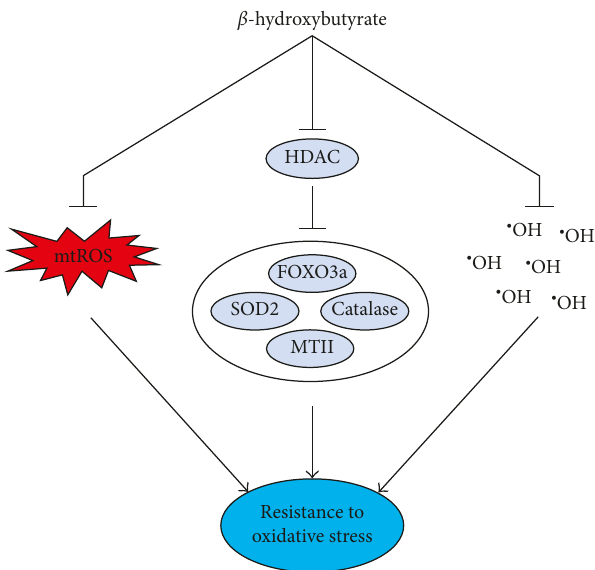
Figure 1: β -hydroxybutyrate and, in some cases, acetoacetate contribute to protection against oxidative stress by decreasing production of mitochondrial reactive oxygen species (mtROS), by increasing expression or protein content of antioxidant enzymes through histone deacetylase (HDAC) inhibition, and by directly scavenging the hydroxyl radical ( • OH). Upregulation of antioxidant enzymes through HDAC inhibition includes manganese superoxide dismutase (SOD2), catalase, and metallothionein II and is likely mediated by the transcription factor forkhead box O 3a